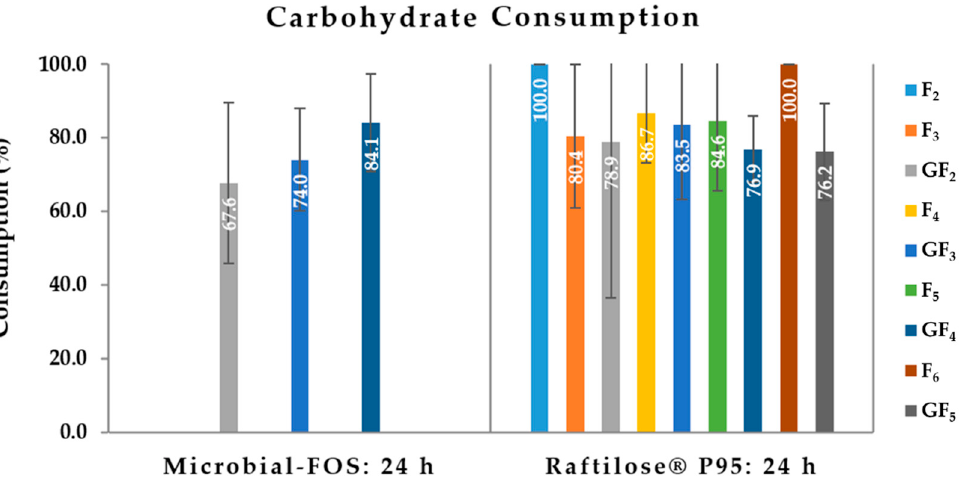
Figure 2. Consumption profile of each carbohydrate present in the microbial-fructo-